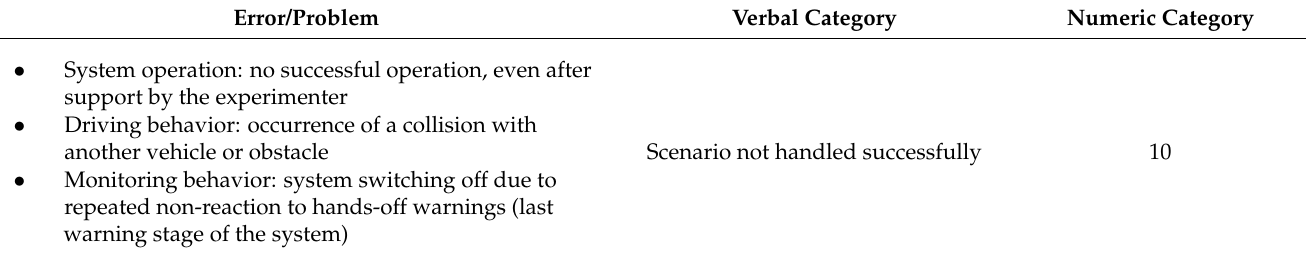
Table 2. Recommendations for global ratings depending on the observed errors or problems.